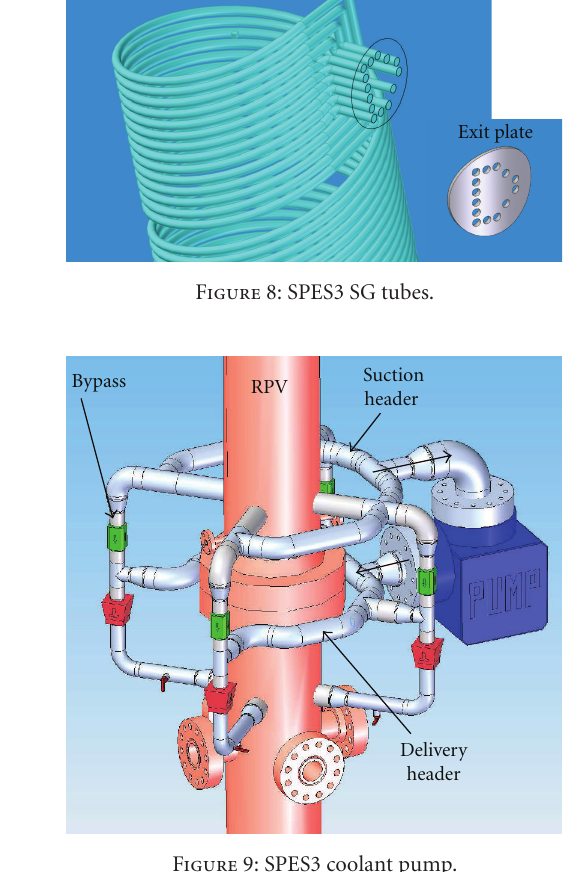
Figure 9: SPES3 coolant